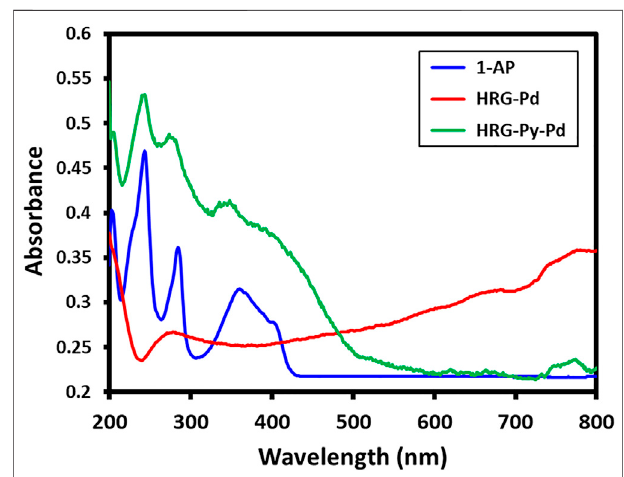
FIGURE 3 | FT-IR spectrum of pure 1-amino pyrene, HRG-Pd, and